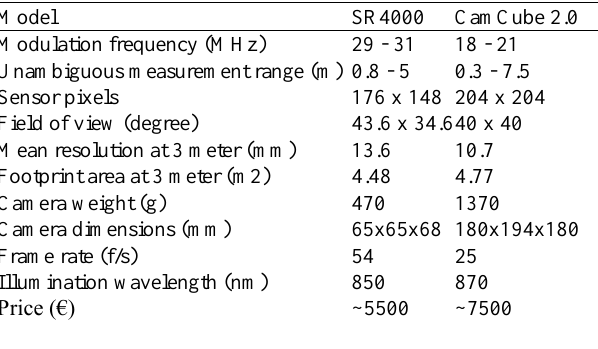
Table 1: Specifications of the used RIM cameras (Nitsche et al.